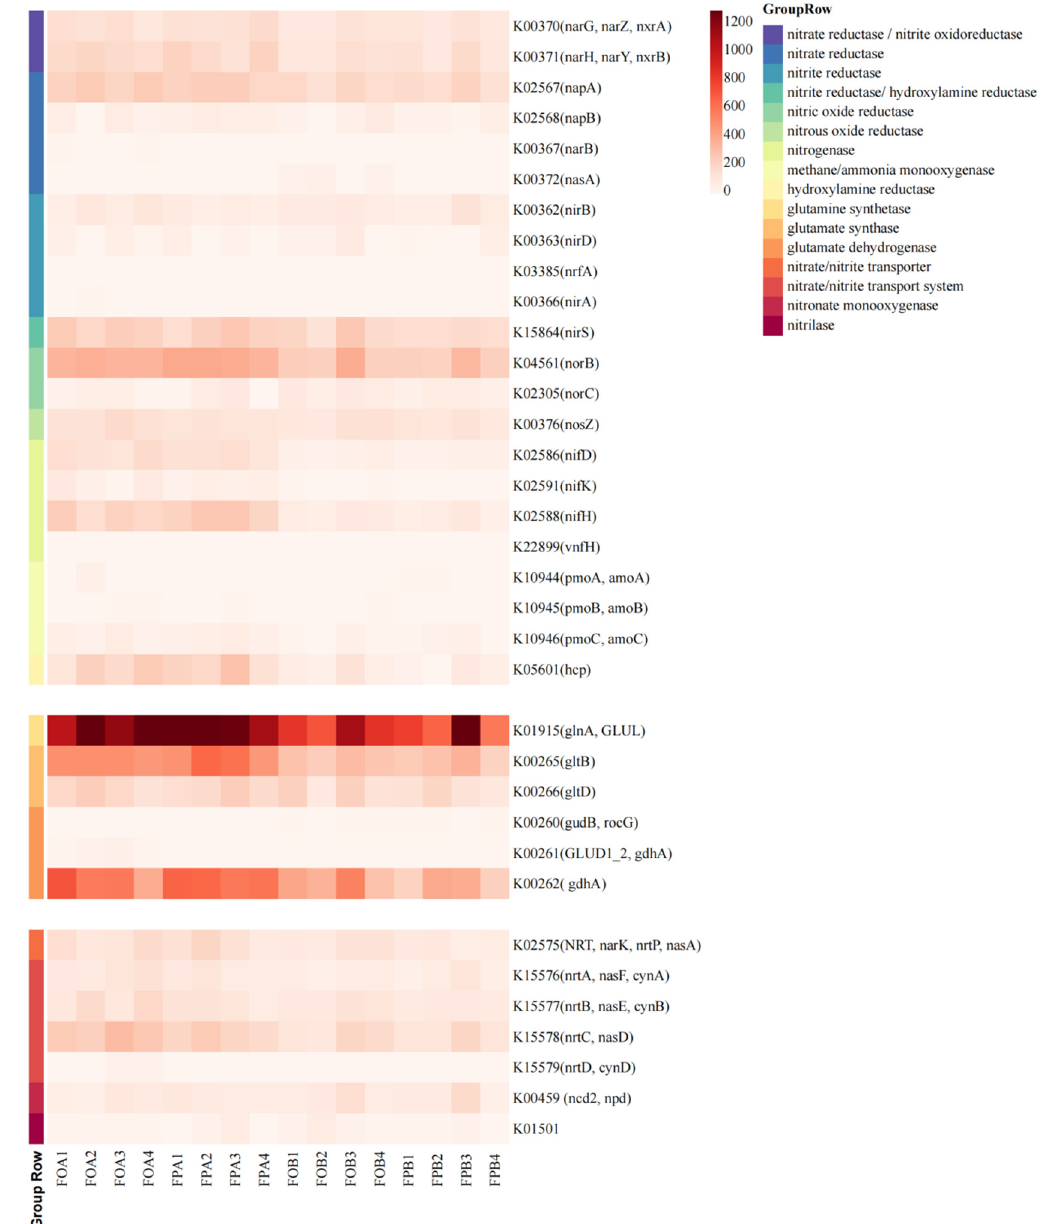
Figure 5. The heat map shows the proportion and abundance of functional pathways and gene families involved in the nitrogen cycle in pond sediments. The numbers on the ordinate represent the nitrogen cycle metabolic pathways annotated by KEGG, and the contents in brackets are the functional genes involved in the metabolic pathway.